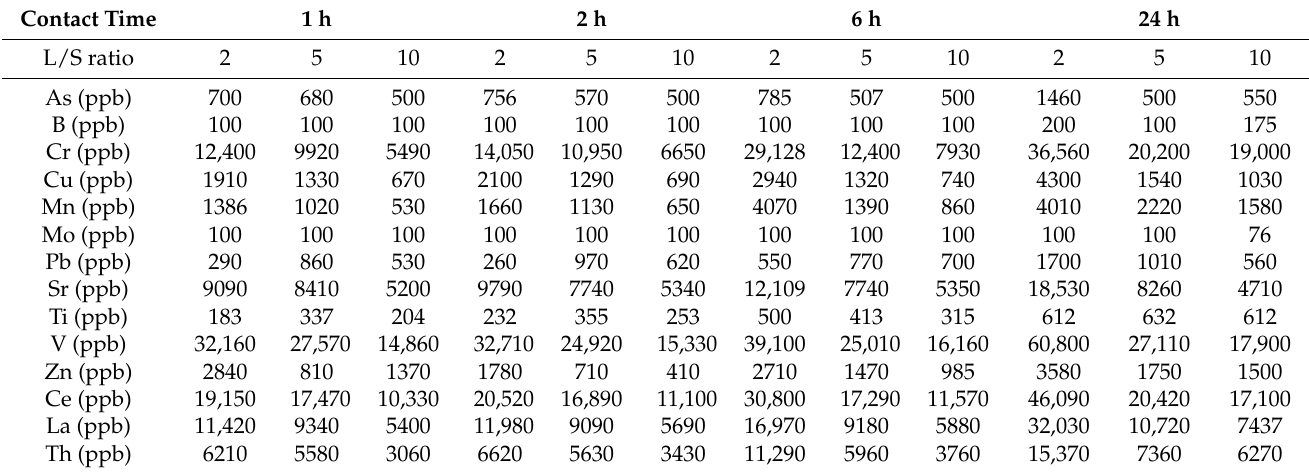
Table 5. Leachates composition in optimization